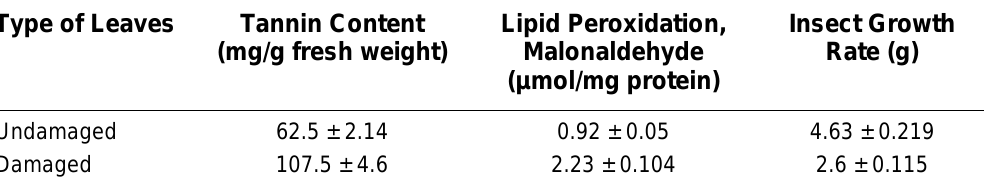
A Profile of Tannin Content, Lipid Peroxidation, and Insect Growth Rate Due to Herbivory on the Mature Leaves of T. arjuna